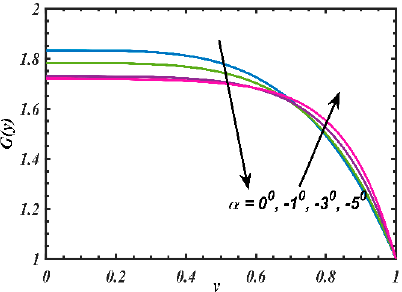
Figure 9. Variation of G(y) in converging for Ec = 0.2, 0.3, 0.4, 0.5 and H = 0, Re = 100, α = − 5 0 , Pr = 5.